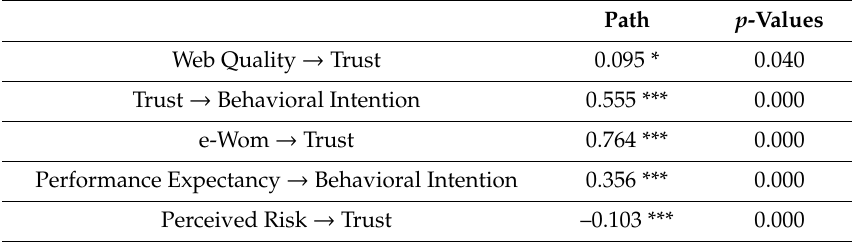
Table 6. Contrast of the structural model (Path Coe ffi